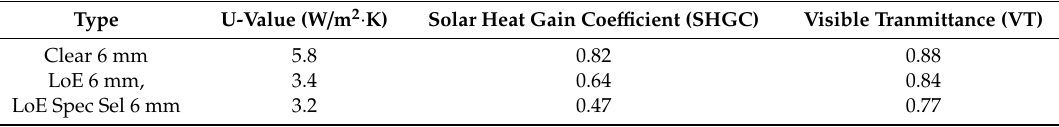
Table 2. Material properties of glazing.